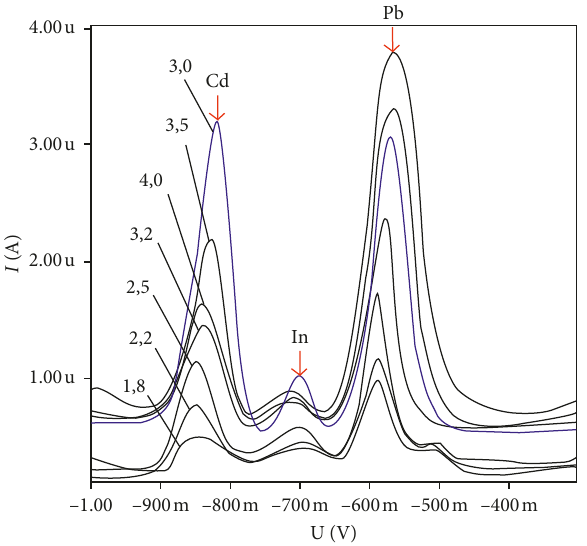
Figure 1: Effect of the electrode diameters at a modified CPE with 5% Bi 2 O 3 (w/w) in the supporting electrolyte mixture of 0.1M KI and acetate buffer. Conditions: E dep � − 1.2V; t dep � 120s; Δ E � 50mV · s − 1 ; speed � 15mV · s − 1